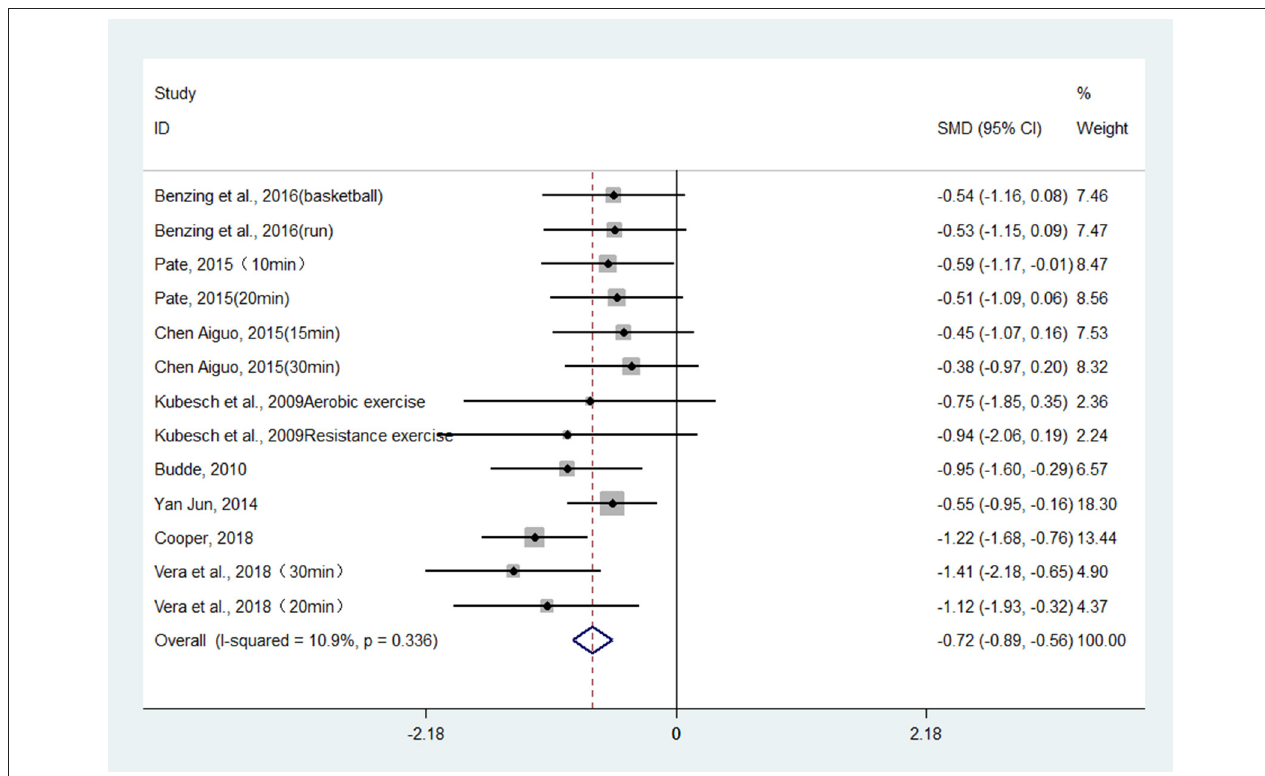
FIGURE 4 | The effect of acute exercises on working memory (SMD = standardized mean difference; CI = confidence